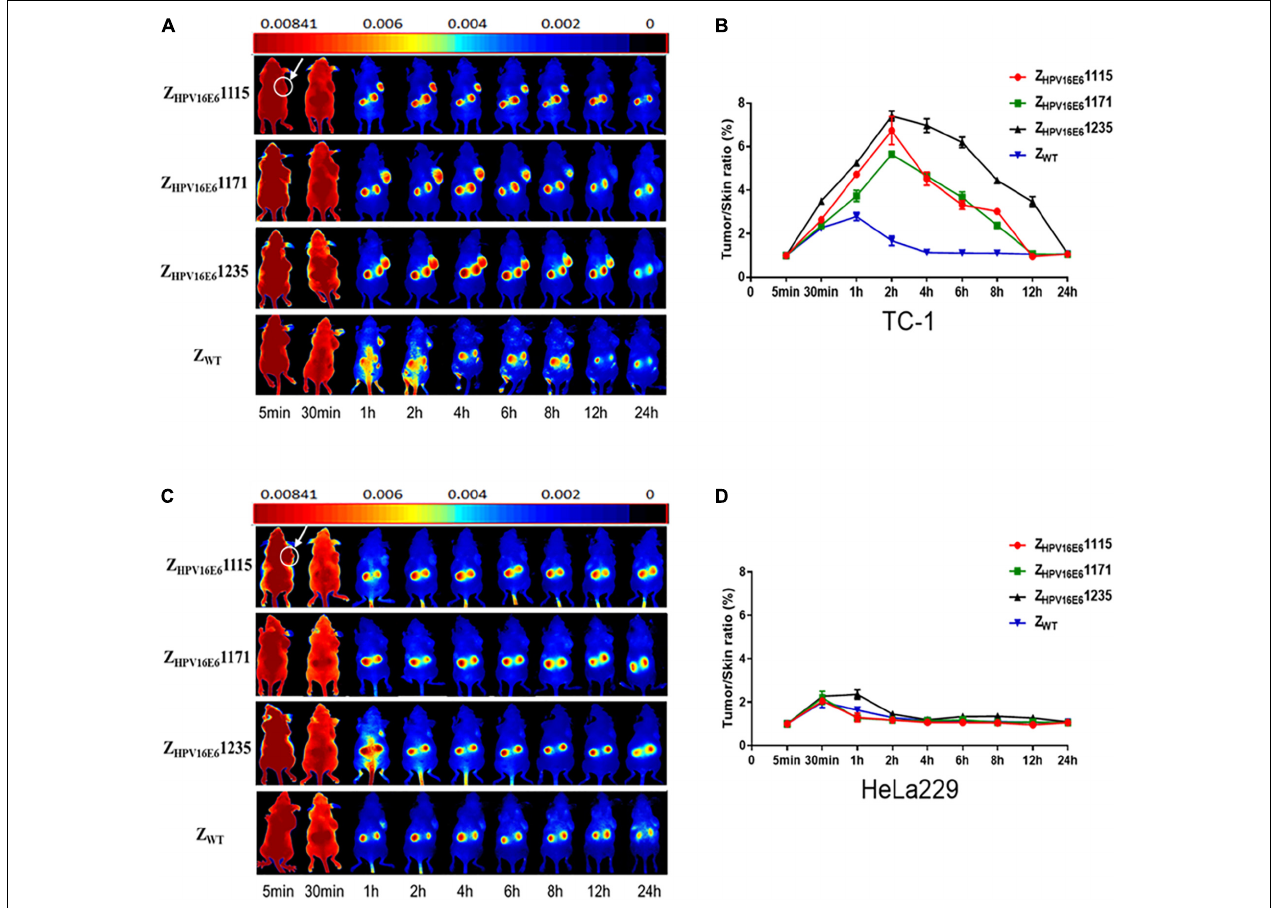
FIGURE 4 | In vivo testing of the target binding ability of Z HPV16E6 affibodies to tumor tissues. Tumor imaging in nude mice bearing TC-1 (A) or HeLa229 (C) xenografts (arrows) by using fluorescence-conjugated affibody molecules. NIR-based imaging was executed at various time points pi with DyLight 755-conjugated Z HPV16E6 affibodies and used DyLight 755-conjugated Z WT affibody as a negative control. Tumor-to-skin ratios were calculated at different time points pi of the indicated agents in nude mice bearing TC-1 (B) and HeLa229 (D) xenografts. Data are shown as the mean ± SD of